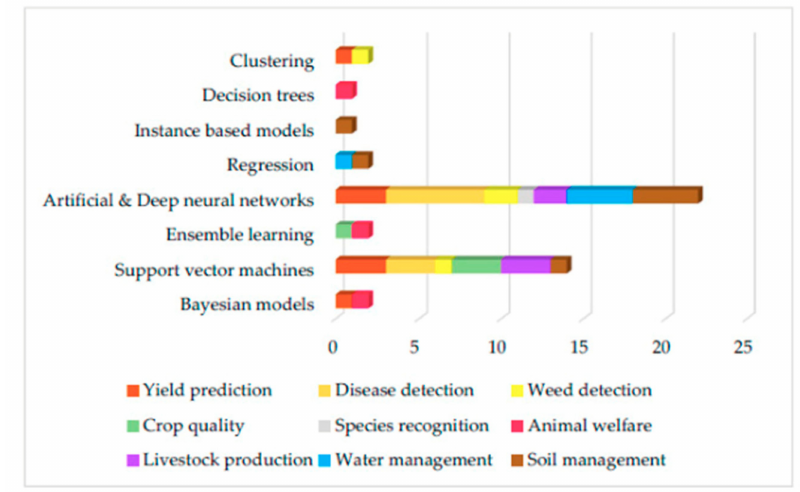
Figure 2. ML techniques used in agriculture [7].